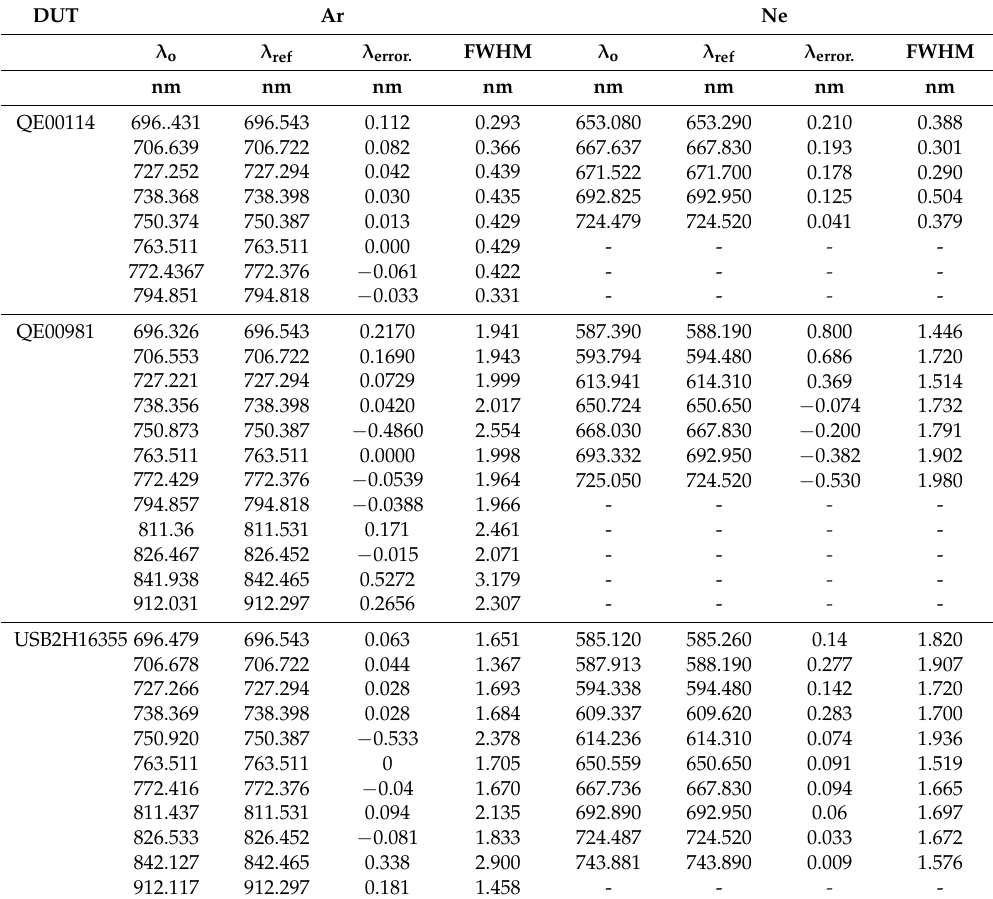
Figure 11. The wavelength corrections for ( a ) Ar and ( b ) Ne lamps’ emission lines measured with spectrometer USB2H1635 ( λ DUT ; DUT, device under test) after optimization at 763.511 nm and the corresponding errors ( c , d ) related to the standard values ( λ standard ). The red lines represent the standard emission lines for Ar and Ne lamps. Table 2. The wavelength differences between Piccolo-corrected wavelength values and the standard Ne and Ar emission lines for spectrometers QEP00114, QEP00981 and USB2H1635. DUT Ar